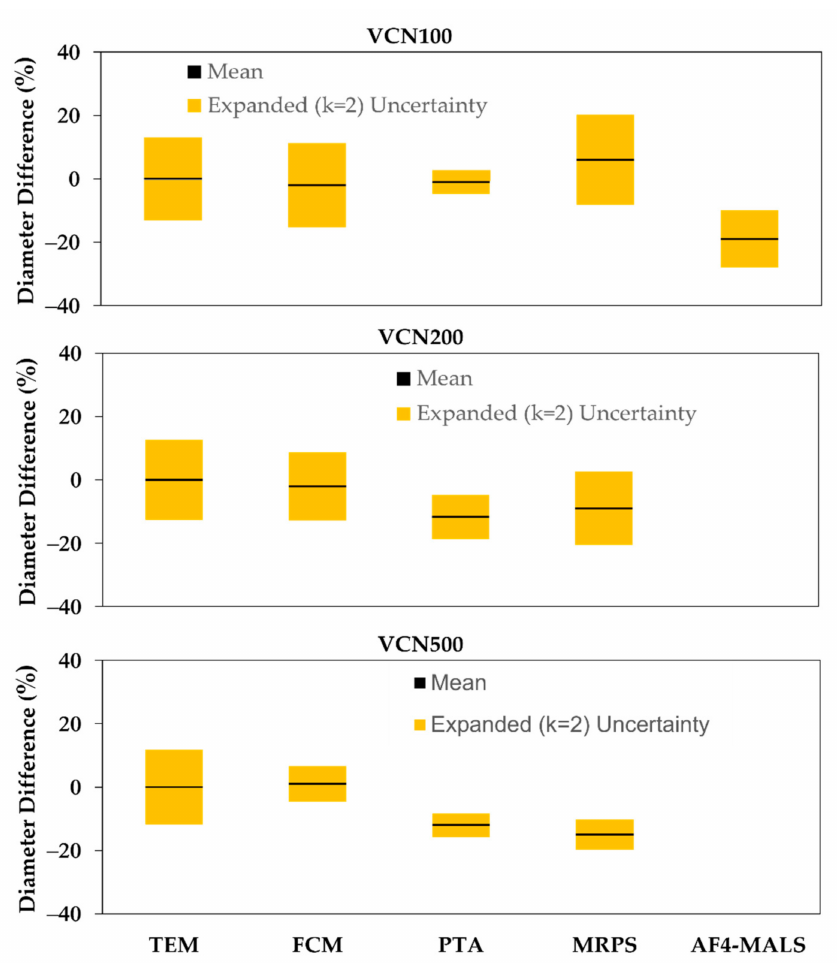
Figure 2. The mean percent difference in measured bead diameter for each technique relative to the TEM value for the VCNs. The error bars show the estimated relative expanded ( k = 2) uncertainties for the TEM and technique